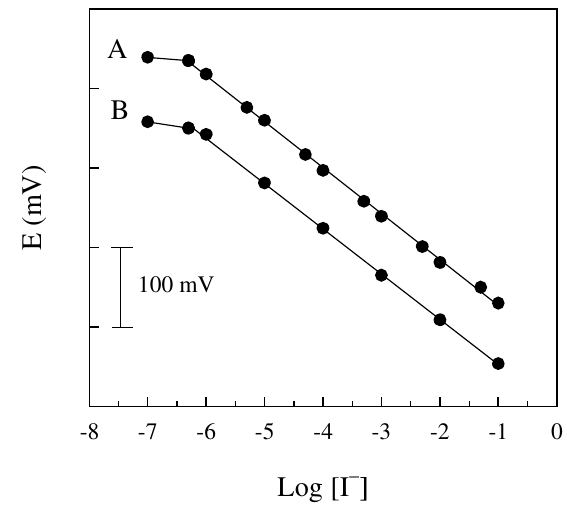
Figure. 3. Calibration plots of the electrodes based on (A) Hg(MBT) 2 and (B) Hg(CTP) 2 carriers. Membrane compositions and measurement conditions are given in Table